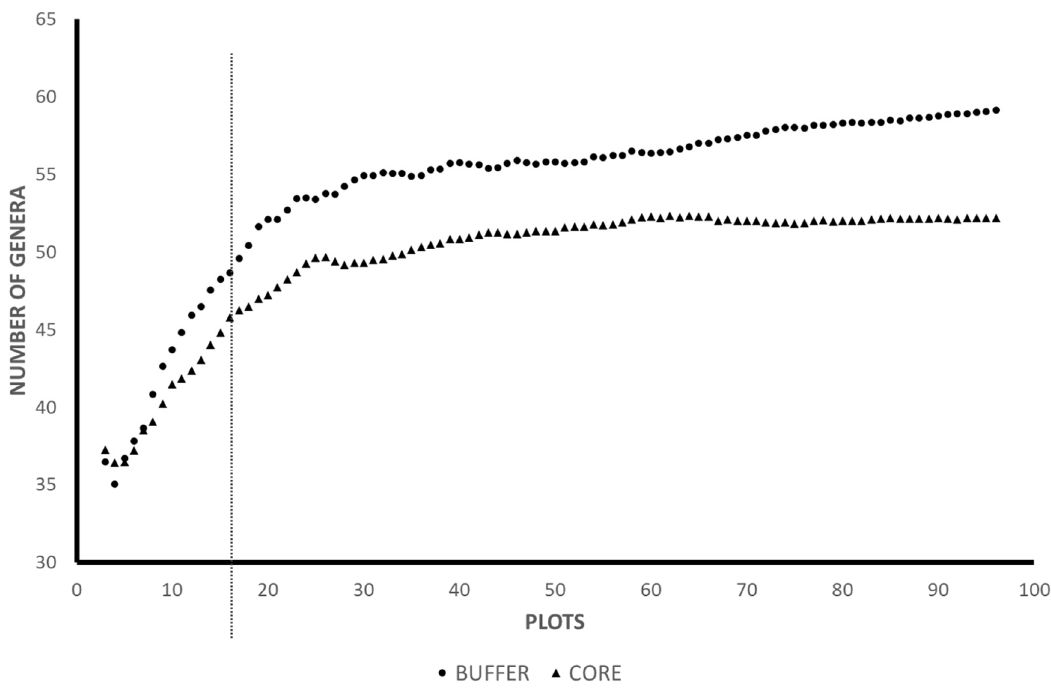
Figure 2. Genus accumulation curves for buffer and core forests. Our 16 plots capture approximately 95% of the genus-level ant diversity present in both core and buffer forests. Symbols represent the cumulative number of genera recorded as the cumulative number of plots increased. Table 1. Relative abundance of all genera collected across all plots. RA = relative abundance. Values represented as proportions.